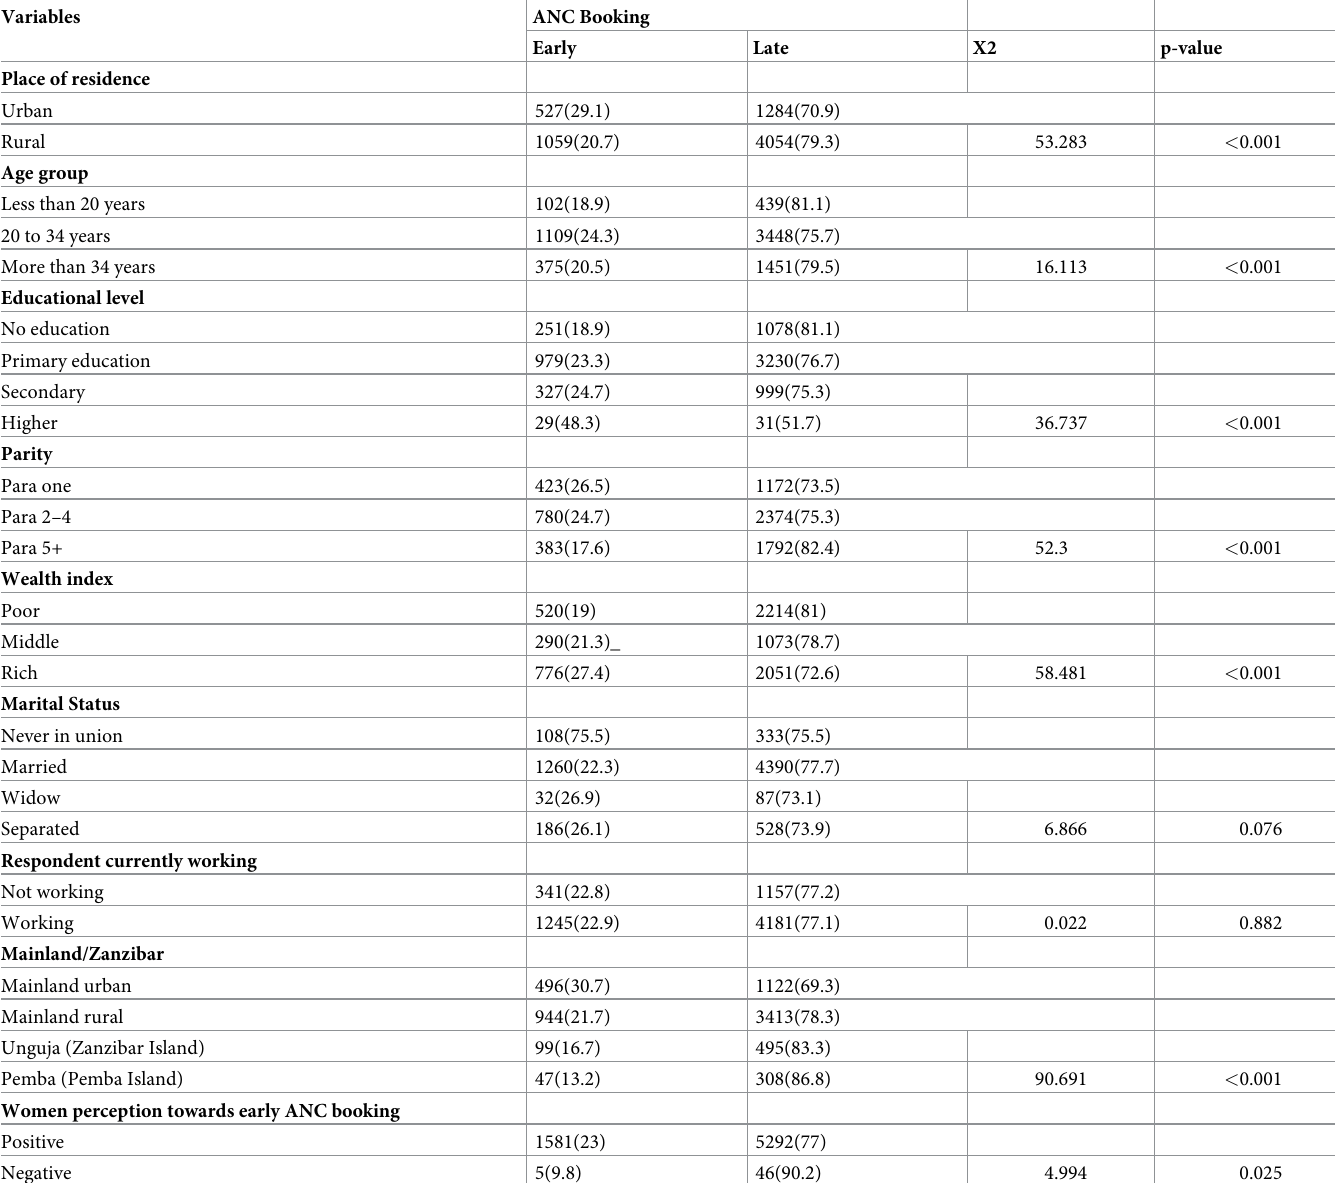
Table 2. The relationship between socio-demographic characteristics and antenatal booking (n =